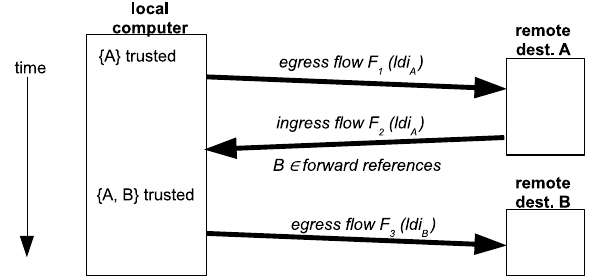
Figure 2. The remote destination B of egress flow F by ldi is trusted, because it was referenced in a prior ingress B flow F of trusted destination A. 2